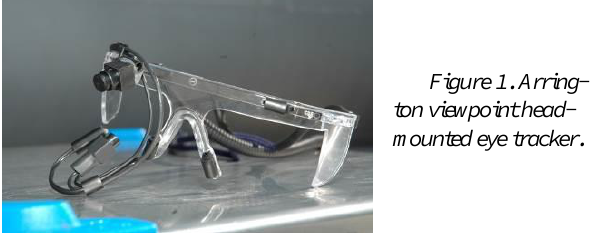
Figure 1. Arring- ton viewpoint head- mounted eye